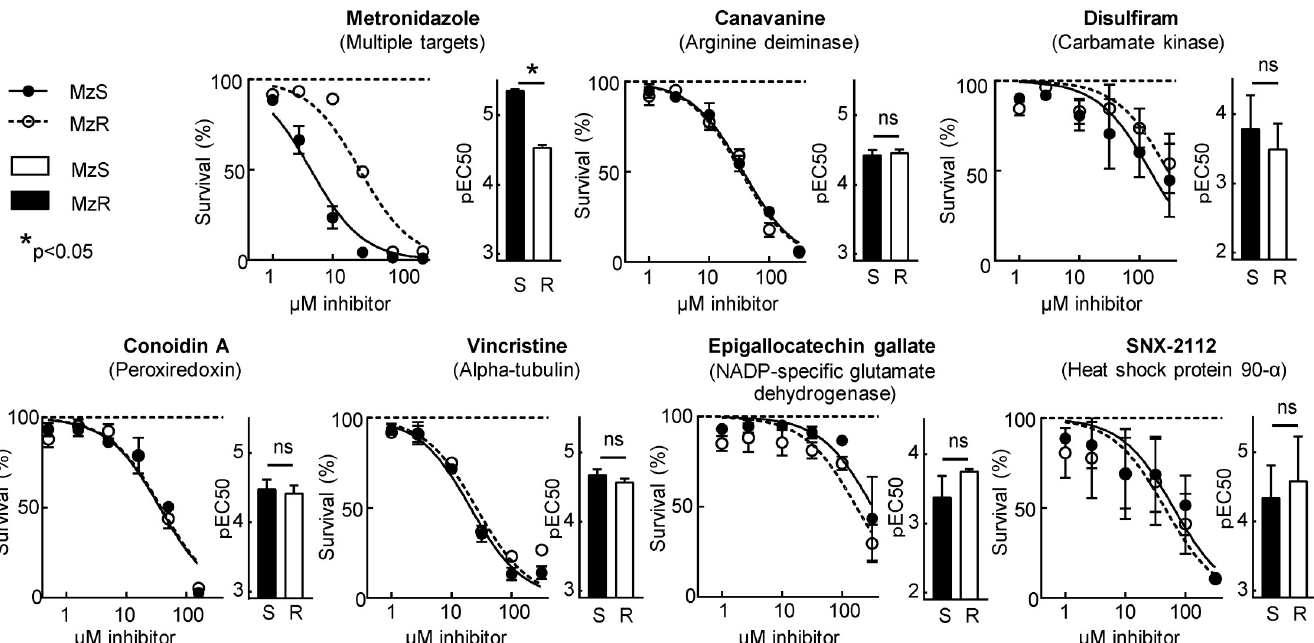
Fig 6. Therapeutic potential of 5-NI drug targets. A MzS and congenic MzR line of G . lamblia WB were tested for susceptibility to the indicated inhibitors of the targets identified by adductomics. The line graphs show concentration-response curves for parasite survival after treatment with the indicated inhibitor concentrations (means ± SE, n = 3–4; horizontal lines represent parasite numbers untreated controls). The bar graphs depict the pEC50 values derived from the concentration- response curves (means + SE, n = 3–4; � p < 0.05 vs MzS cells,; ns, not significant).